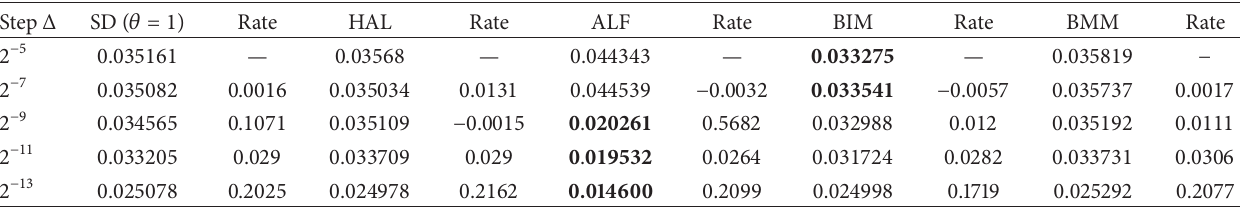
Table 1: 98% error and step size of fully implicit SD, HAL, ALF, BIM, and BMM scheme for (2) with (𝑥 0 , 𝑘 1 ,𝑘 2 , 𝑘 3 ,𝑞,𝑇) = (1/16,1/16, 1, 0.4, 3/4, 1) .